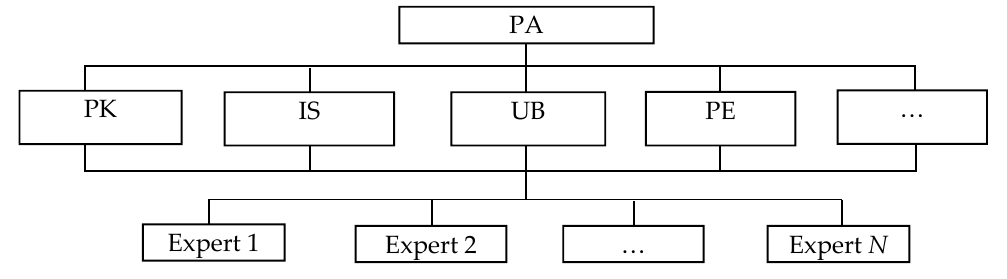
Figure 2. Bow-tie model of pipeline failure accidents. 198